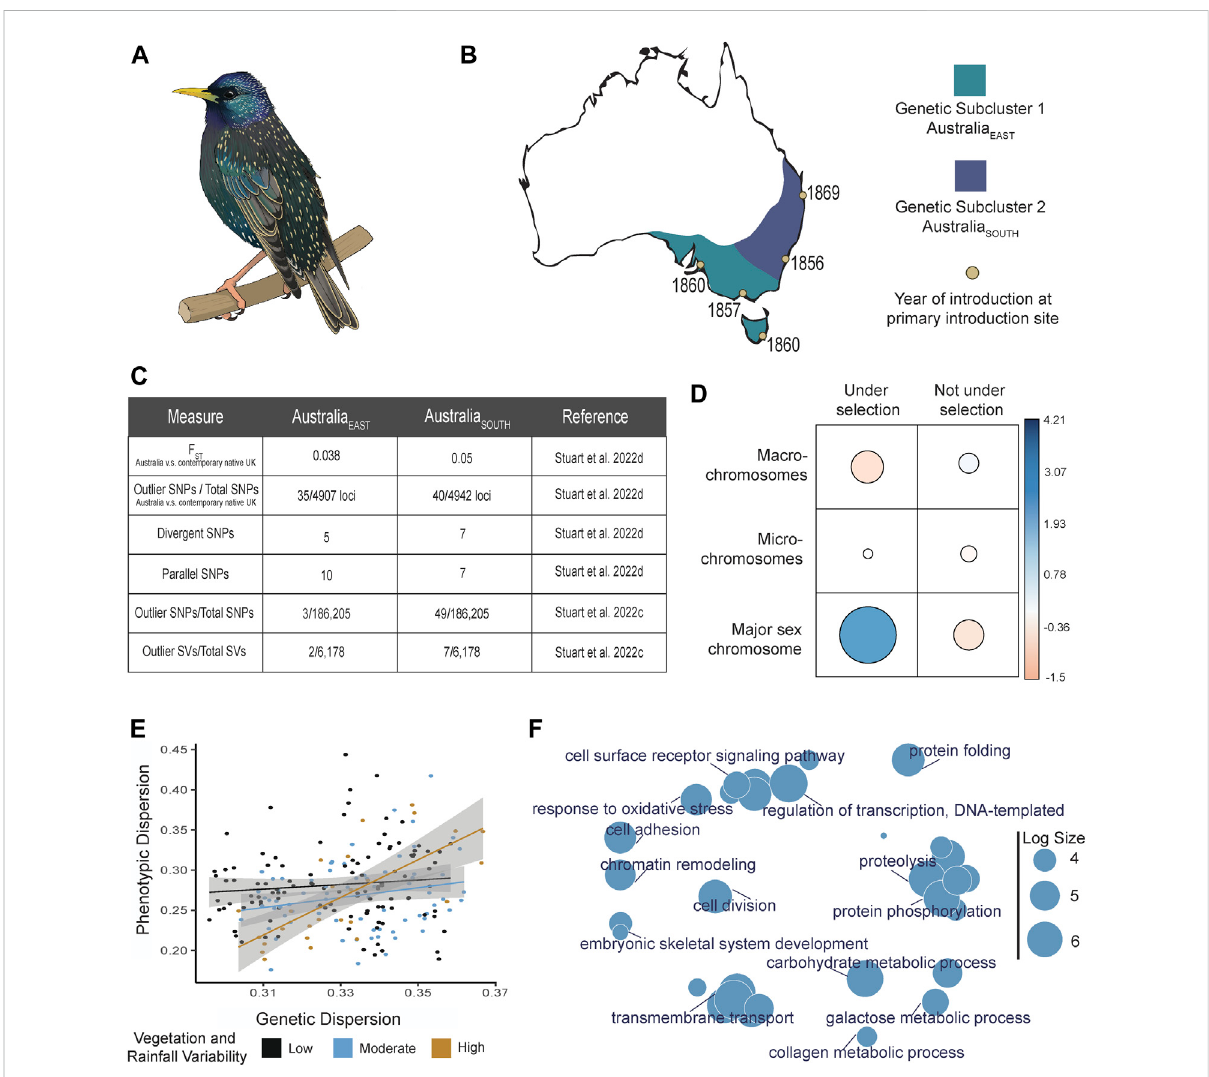
FIGURE 1 Summary diagram of evolutionary trends for Sturnus vulgaris ( S. vulgaris ) within the invasive Australian range. Panel (A) depicts an artist ’ s image of a male S. vulgaris in breeding season. Panel (B) depicts the Australian range of S. vulgaris (approximately based on eBird data retrieved 2018), with approximategeneticsub-structuringindicatedinpurple(Australia EAST )andblue(Australia SOUTH ),andwithintroductionsitesindicated(yellowcircles) next to the year of fi rst introduction. Panel (C) depicts differences in genetic differentiation between the two Australian subpopulations (Australia EAST andAustralia SOUTH )andthenativerange.F ST valueswereobtainedfromcomparisonstoNewcastle,UK,fromStuartetal.(2022d).Panel (D) depicts a subset of the chi-squared results that assessed the occurrence of putative outliers and non-outlier SNPs across macro-, micro-, and majorsex(Z)chromosomefromStuartetal.(2022d).ThetablevisualisesthePearsonresiduals,wherethecircleareaisproportionaltotheamountof the cell contribution, positive residuals (indicating a positive correlation) are in blue, and negative residuals (indicating a negative correlation) are in orange.Panel (E) depictsthepositiveinteractionbetweenphenotypicandgeneticdispersion,whichispositivelyaffectedbythelevelofgroundcover vegetation and annual precipitation variation, data pulled from Stuart et al. (2022a). Panel (F) depicts a REVIGO (Supek et al., 2011) gene ontology term summary plot of all coding regions that were identi fi ed as signi fi cant across loci identi fi ed in studies on the Australian starling population: all statistically-outlier and environmentally-associated loci (Stuart et al., 2021); all divergent and parallel loci (Stuart et al., 2022d); all statistically outlier SNPs and SVs identi fi ed by BAYESCAN v2.1 (Foll and Gaggiotti, 2008) (Stuart et al., 2022c); all morphologically-associated loci that were also under selection (Stuart et al., 2022a). Log size is indicative of the frequency of the GO